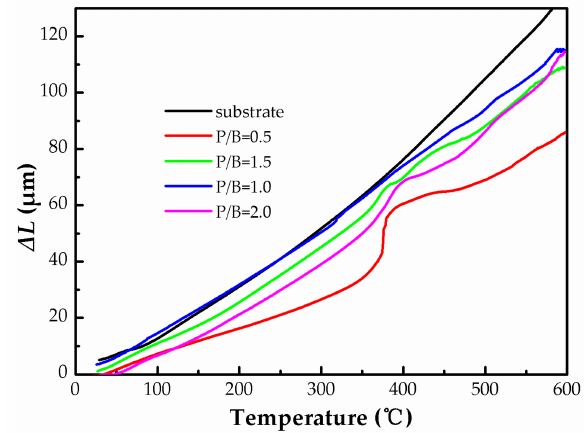
Figure 7. Thermal mechanical analysis (TMA) curves of polysiloxane/Al coatings with different P/B ratios, the ∆ L means the size defference in the sample at temperature T and at room